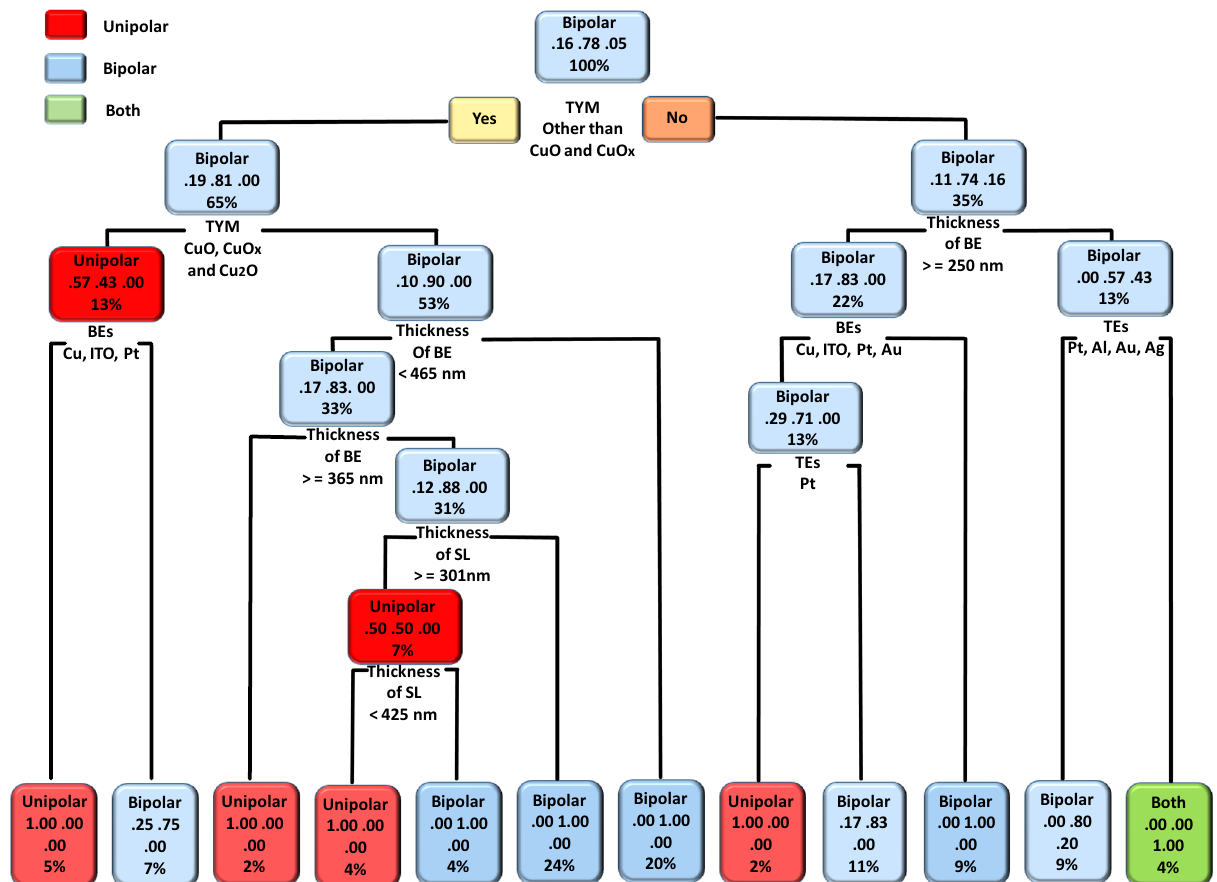
Figure 4. The DT model of the type of switching (unipolar, bipolar, or both). The present model suggests an impact of device fabrication parameters on the type of switching (unipolar, bipolar, or both) of copper oxide- based RS